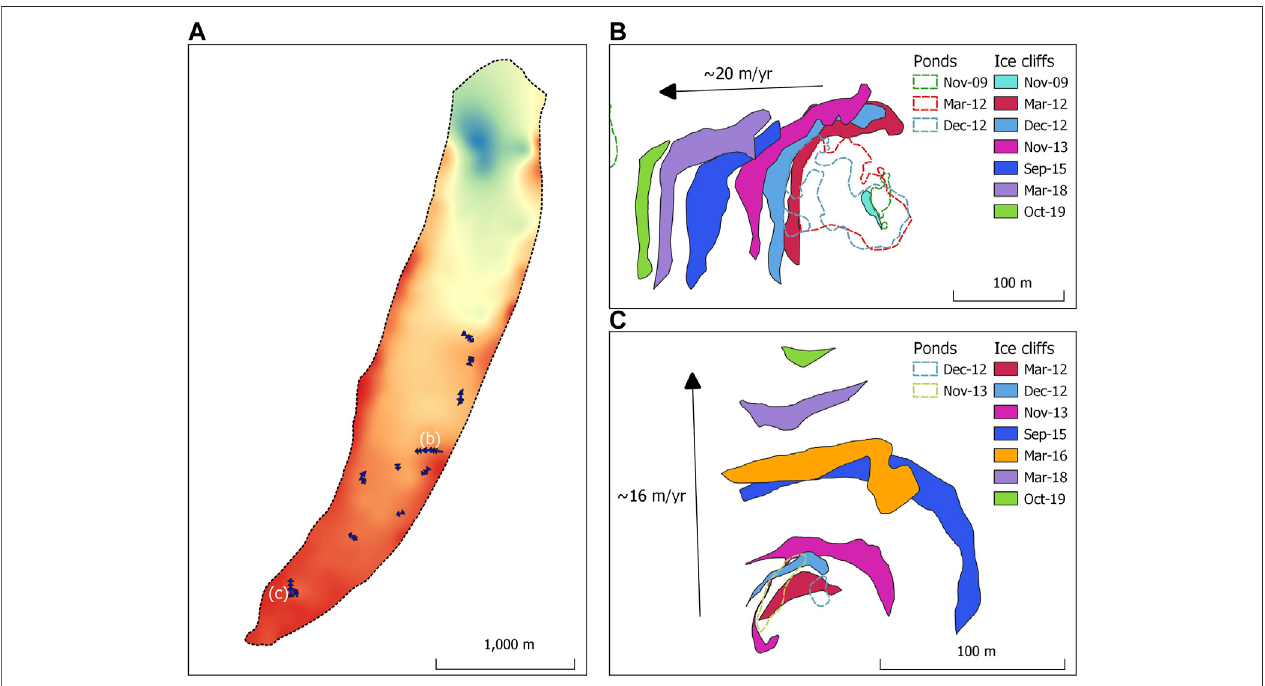
FIGURE 7 | (A) Direction and length of retreat of 11 ice cliffs on the debris-covered tongue of Verde glacier. Colormap corresponds to the spline interpolation of surface velocity of Figure 6B . (B) and (C) refer to the right panels showing detailed time-lapse retreat of two selected ice cliffs and the associated